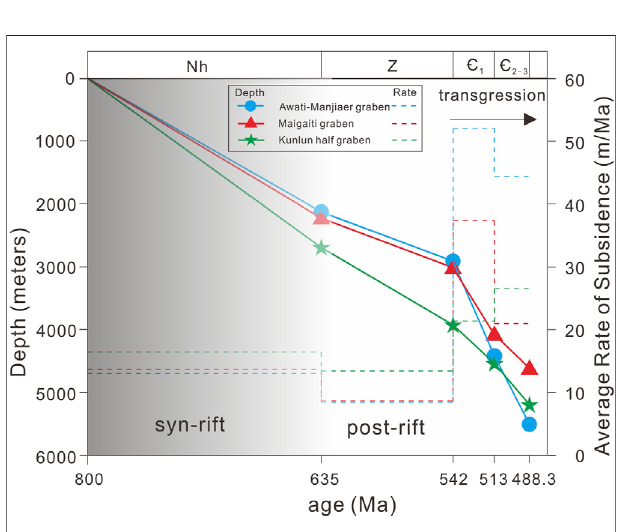
FIGURE 11 | Simpli fi ed subsidence curves and the average rate of subsidence for three locations in the Tarim Basin. Locations of the grabens and half-grabens are shown in Figure 6